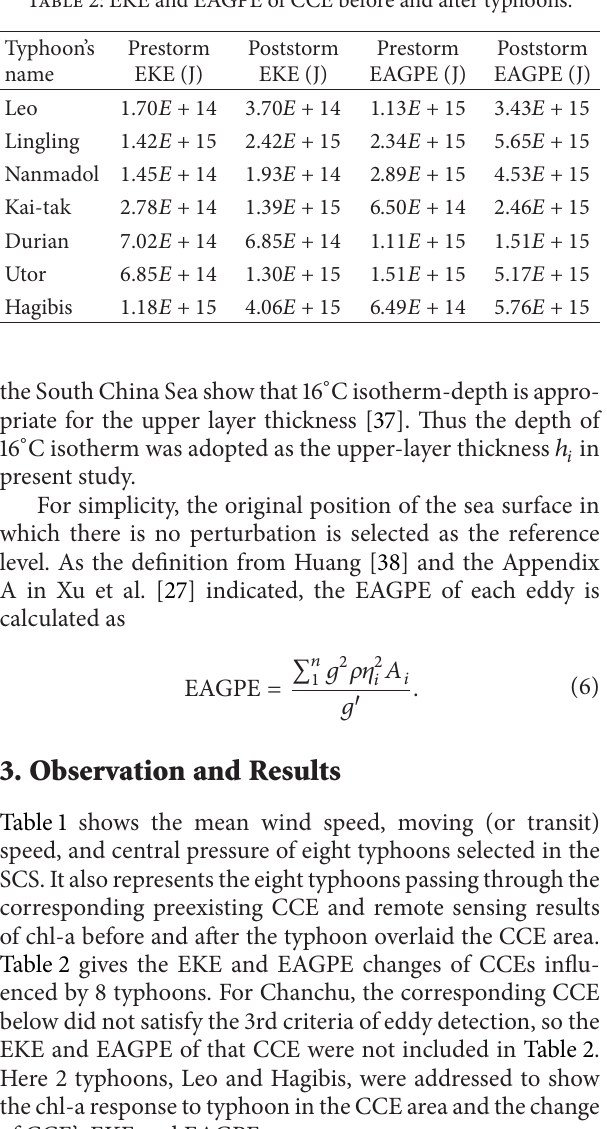
Table 2: EKE and EAGPE of CCE before and after